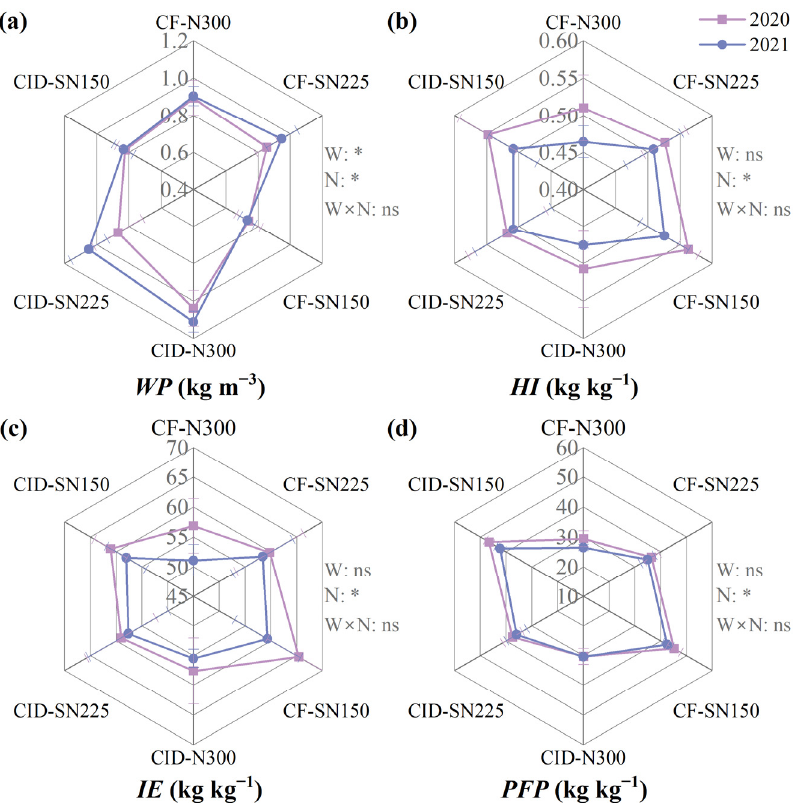
Figure 7. ( a ) Comparison of water productivity ( WP ), ( b ) harvest index ( HI ), ( c ) internal nitrogen-use efficiency ( IE ), and ( d ) partial factor productivity of nitrogen ( PFP ) for various water and fertilizer treatments. CF and CID represent continuously flooded and controlled irrigation and drainage, respectively. N300 denotes conventional farmers’ fertilization of 300 kg N ha − 1 without straw return. SN225 and SN150 denote straw return with 225 and 150 kg N ha − 1 fertilizer, respectively. * and ns represent p < 0.05 and nonsignificant based on the LSD test,